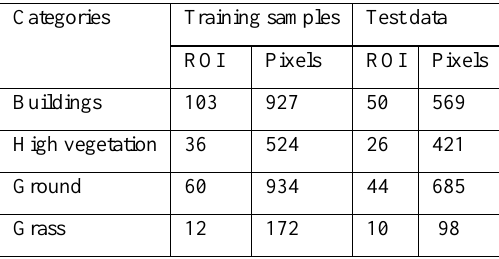
Table 1. The training samples and test